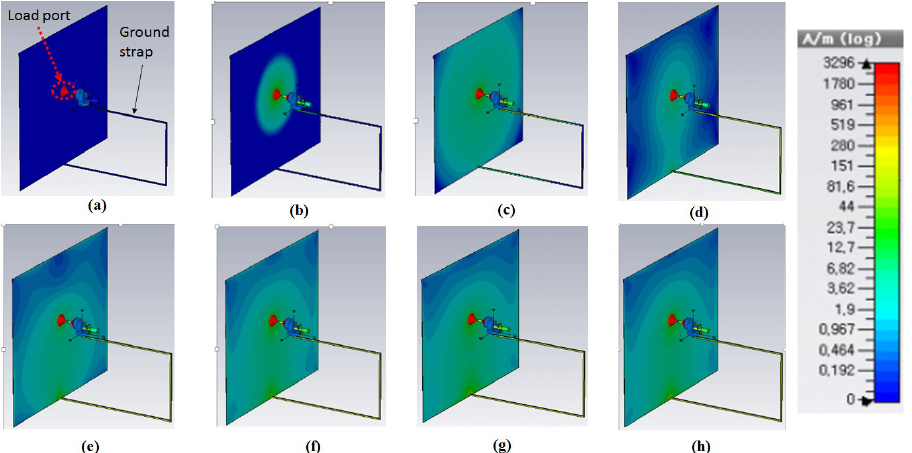
Figure 5. Current distribution for Noiseken gun model of Figure 2b for +4 kV voltage level: ( a ) 0 ns; ( b ) 1 ns; ( c ) 2.5 ns; ( d ) 4.5 ns; ( e ) 7 ns; ( f ) 20.5 ns; ( g ) 30 ns; and ( h ) 50 ns (the red part at the center of board as explained in a is of the load port not the color of current distribution).